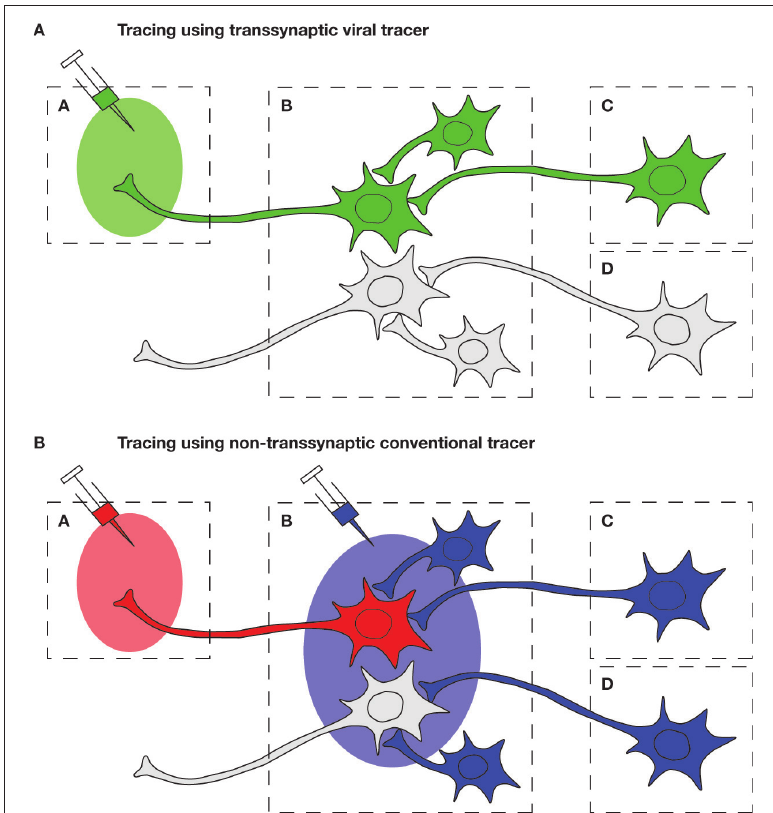
Figure 1 | Schematic diagram of the comparison of viral and conventional tracers in tracing neural circuits which converge to Region A. (A) By injecting a retrograde viral tracer into Region A, the virus will first infect the neurons that directly project to the injection site (first-order neuron) in Region B, and then spread further to the synaptically connected upstream neurons (second-order neuron) in Region C. Therefore, transsynaptic labeling enables us to trace chains of specific neurons, such as projection neurons which interconnect distinct brain regions or interneurons which modulate the activity of such projection neurons. (B) By using conventional non-transsynaptic tracers, several experiments with different injection sites must be conducted in order to reveal the afferent neural circuits: injection to Region A to detect first-order neurons, and injection to Region B to detect second-order neurons. However, in this way, neurons that are not connected with the circuit A may also be stained, such as the neuron in Region D.